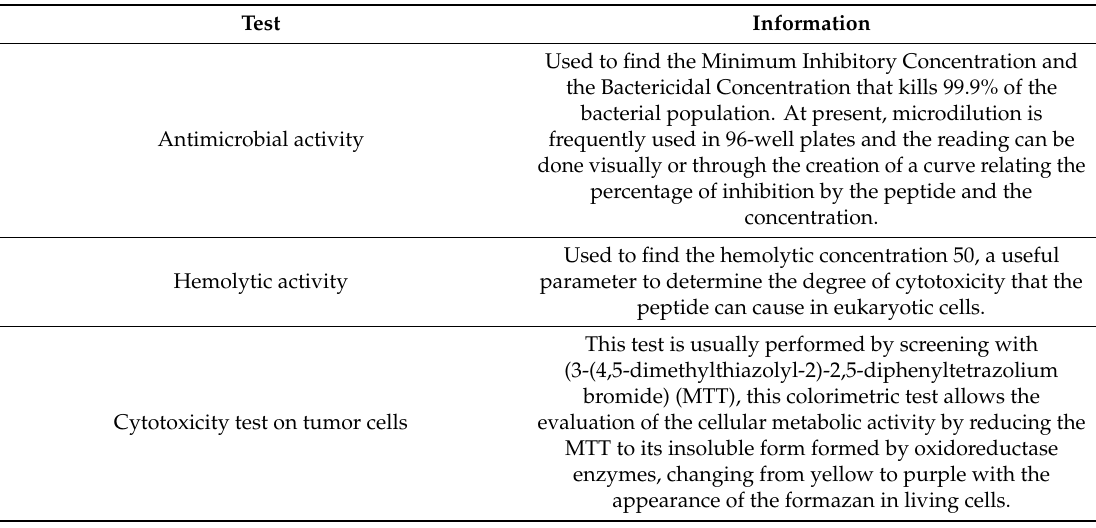
Table 2. Test for peptides with dual antimicrobial-anticancer activity [45–53].